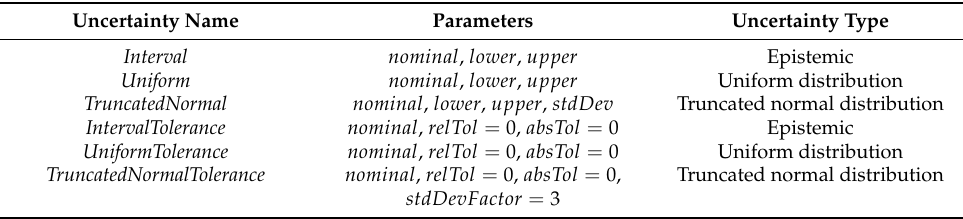
Table 1. Examples for the proposal to define uncertainty descriptions with generic and tolerance parameterizations of scalar parameters. Default values are given with “=. . .” , such as “ relTol = 0”. A truncated normal distribution is defined by the nominal value (= mean value) and the standard deviation stdDev of the underlying normal distribution, besides lower and upper limits.